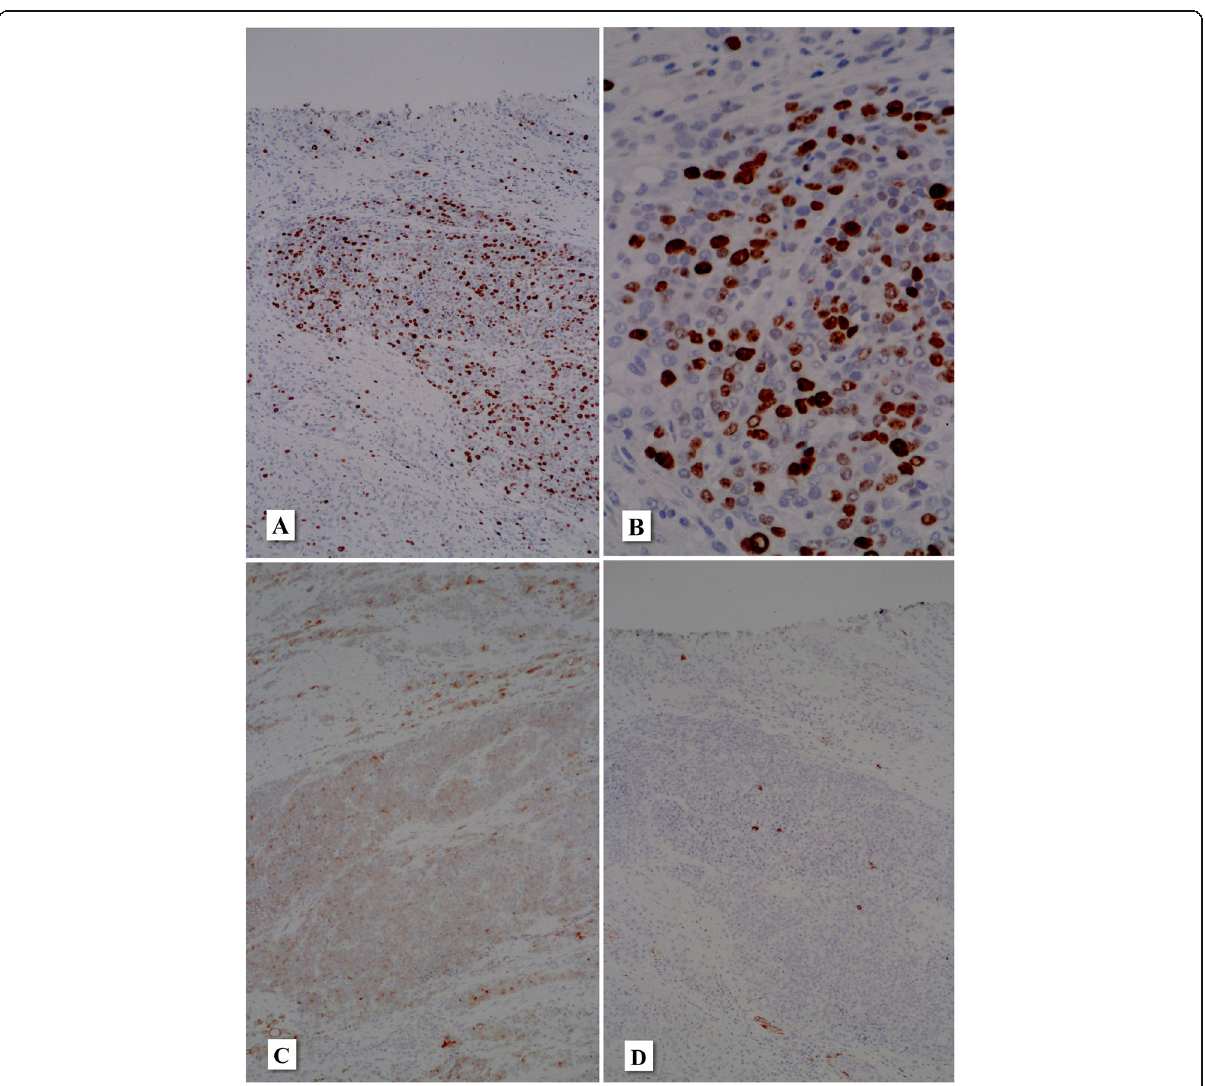
Fig. 8 Immunophenotype of a 3.5-mm focus of poorly differentiated carcinoma. Ki67 with proliferation index of about 50% (Ki67: A , 100x, and B : 400x). Weak to absent expression of PSA ( C : PSA, 100x) and synaptophysin expression in scattered cells ( D : Synaptophysin,